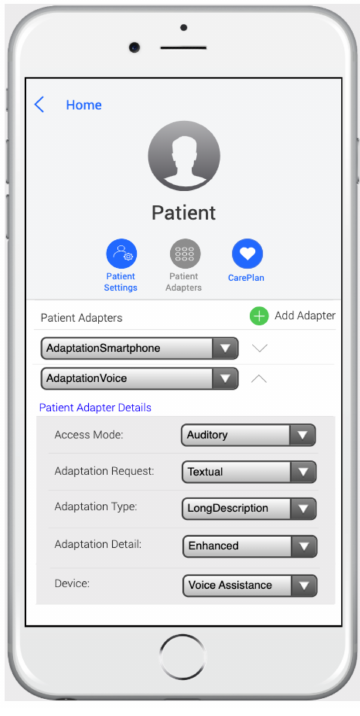
Figure 11. Web app for the MoSIoT scenario